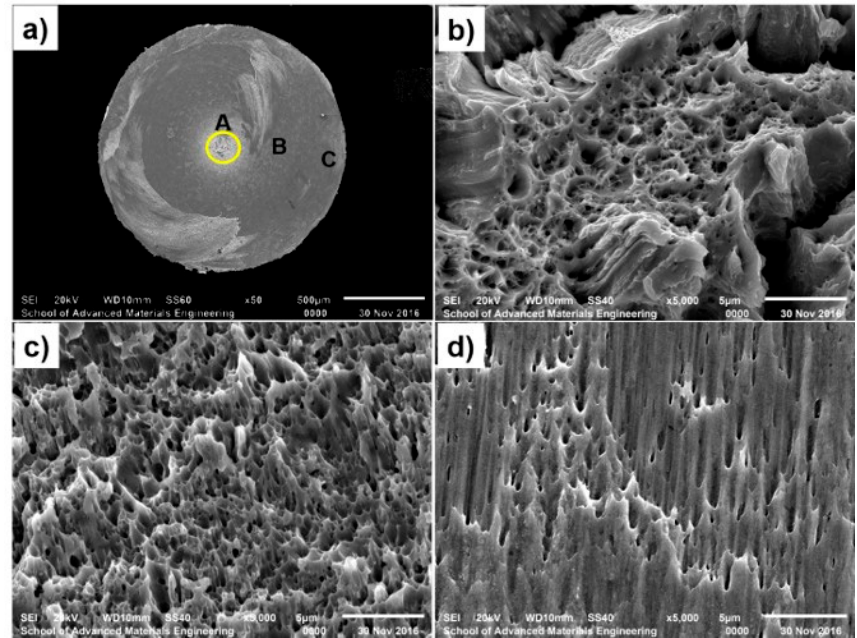
Figure 5. ( a ) Ductile torsion fracture surface of cold drawn steel wire with a strain of 2.38, ( b ) dimples in the center region (marked A in ( a )), ( c ) elongated dimples in one quarter region of a diameter (marked B in ( a )), and ( d ) elongated dimples at the surface (marked C in ( a )).